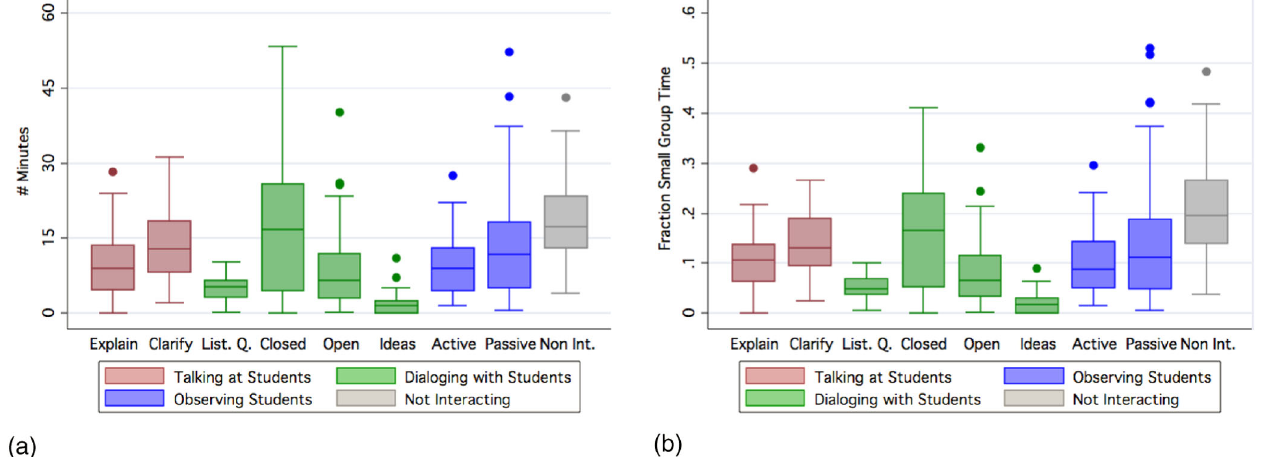
FIG. 4 (color online). Breakdown of small group time. (a) The number of minutes of small group time dedicated to each type of interaction. (b) The percentage of small group time in each type of interaction. Note that the category ‘‘Ideas’’ contains only 35 observations because we added the category late. In the other 24 observations all ideas were categorized as open dialogue.